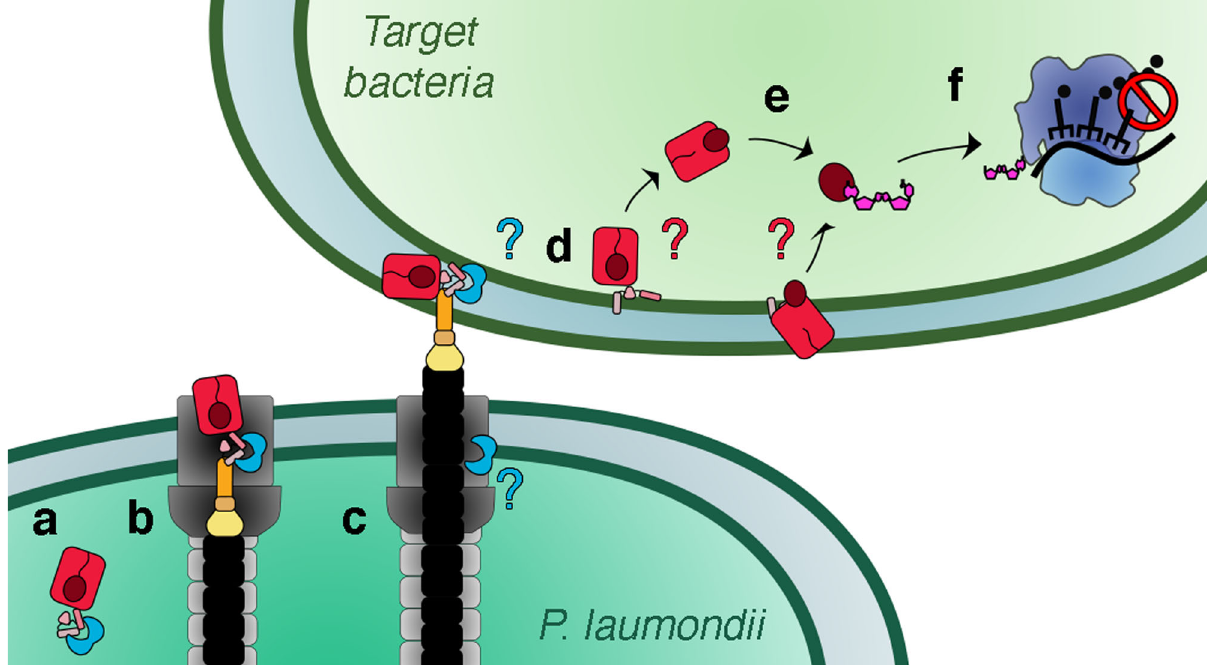
Fig. 5 Model for Rhs loading and delivery by the type VI secretion system. a The EagR chaperone (blue) binds to the Rhs NT hydrophobic domains to stabilize the Rhs protein (red) prior loading on the T6SS. b The Rhs protein is loaded on the C-terminus of the VgrG spike (orange) via its N-terminal prePAAR-PAAR domain. c Sheath contraction propels the inner tube (black) to inject the VgrG loaded with Rhs into the target cell. It is not known whether the EagR chaperone remains in the attacker cell or whether it is translocated together with the VgrG-Rhs complex. d The Rhs1 protein is directly delivered in the cytoplasm, or if delivered in the periplasm, the Rhs NT hydrophobic transmembrane domains insert into the inner membrane of the target cell and are used to translocate the Rhs β -barrel and/or the toxic domain into the cytoplasm of the target cell. Alternatively, the Rhs β -barrel itself inserts into the membrane. e N- and C-terminal autoproteolysis opens the Rhs shell and releases the Rhs CT toxin into the target cell cytoplasm. f The P. laumondii Rhs1 C-terminal toxin domain, Tre23, arrests translation by ADP-ribosylation of the 23 S